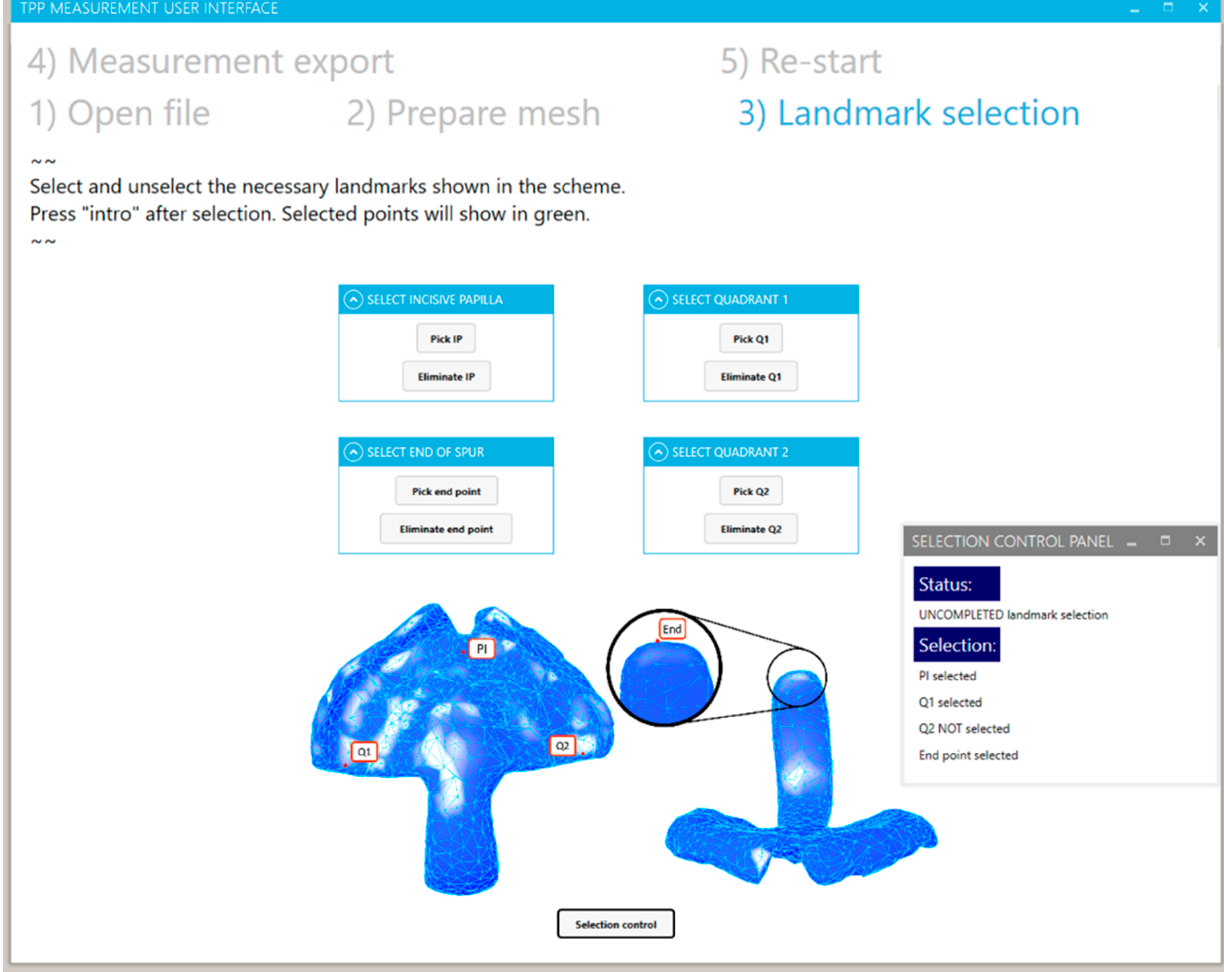
Figure 15. User interface view for the “landmark selection” and “selection control panel” for the completeness control of the process.